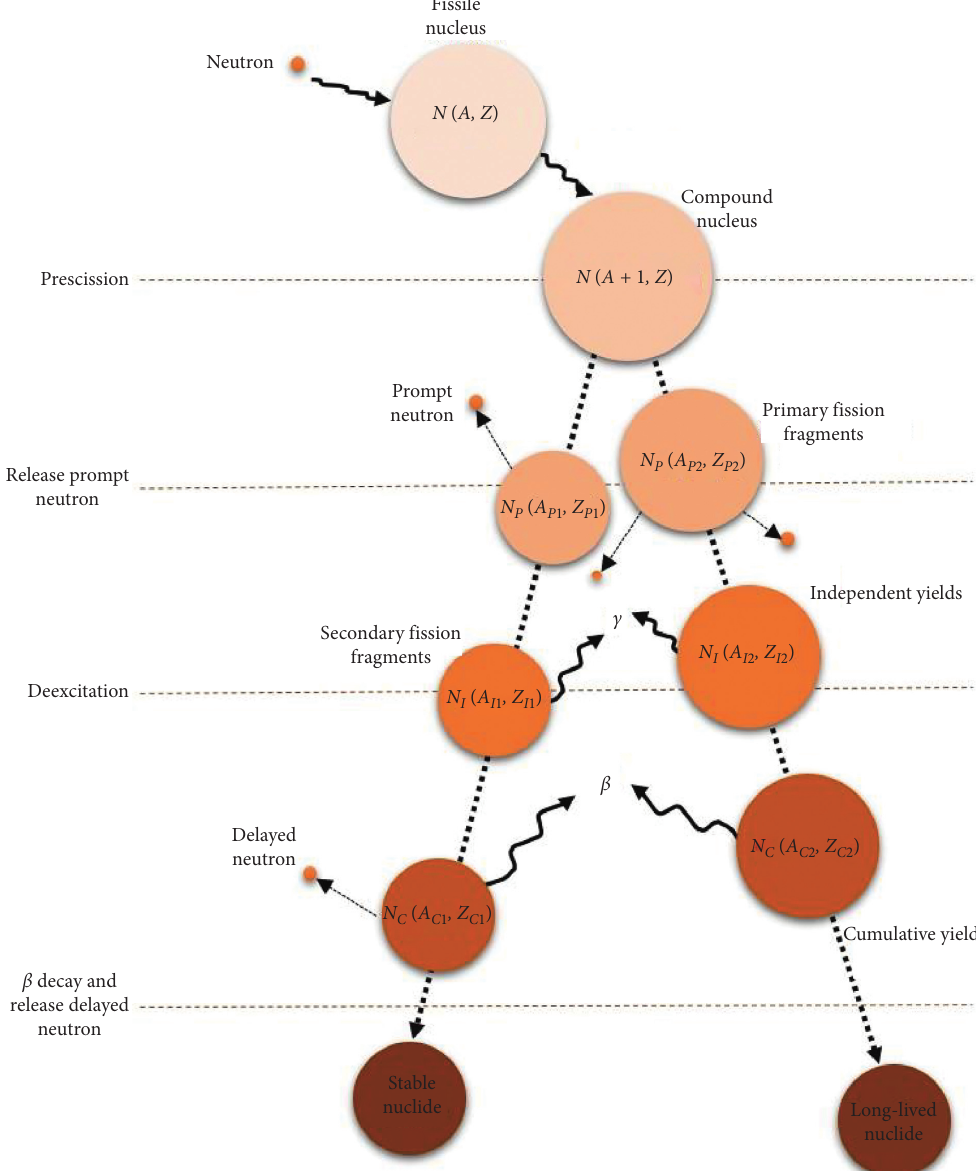
Figure 1: Neutron induced fission process [21]. The fission products refer to the fission fragments after the emission of prompt neutrons. Independent fission yields (IFYs) characterize the fraction of a fission product produced before any radioactive decay, whereas cumulative fission yields (CFYs) describe the fraction of that produced product over all time after a